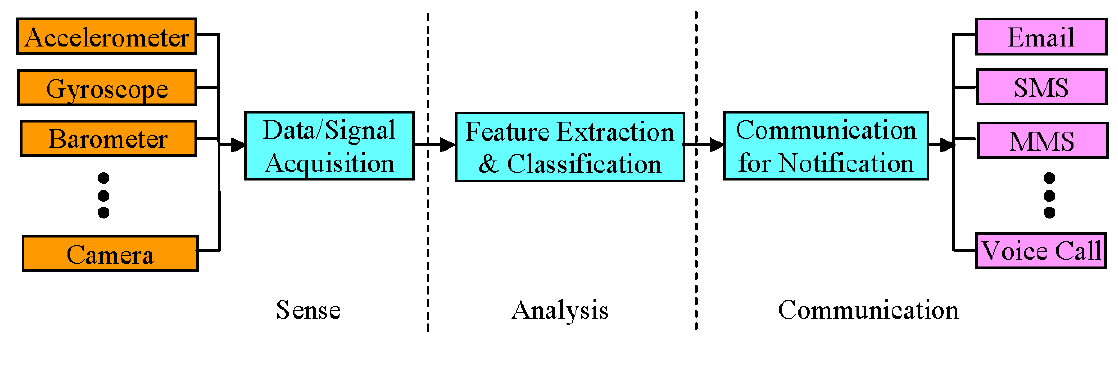
Figure 1. Common basic architecture of fall detection and fall prevention